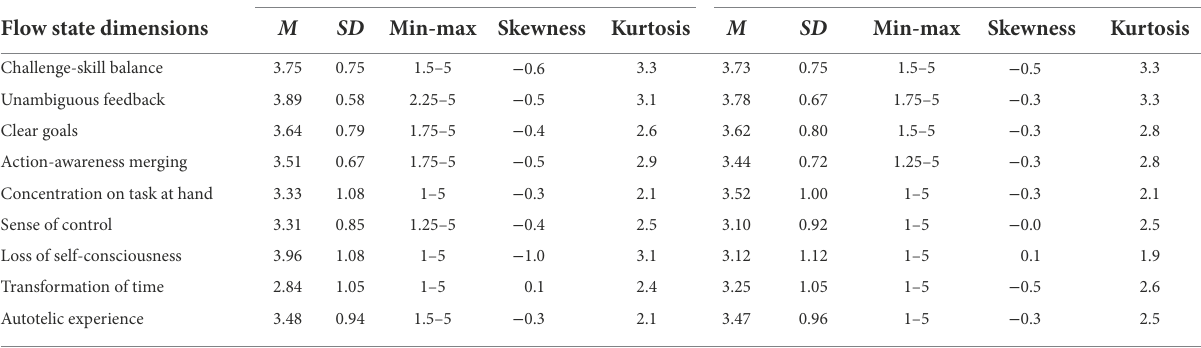
TABLE 2 Descriptive statistics for the outcome